Question: What type of chart is this?
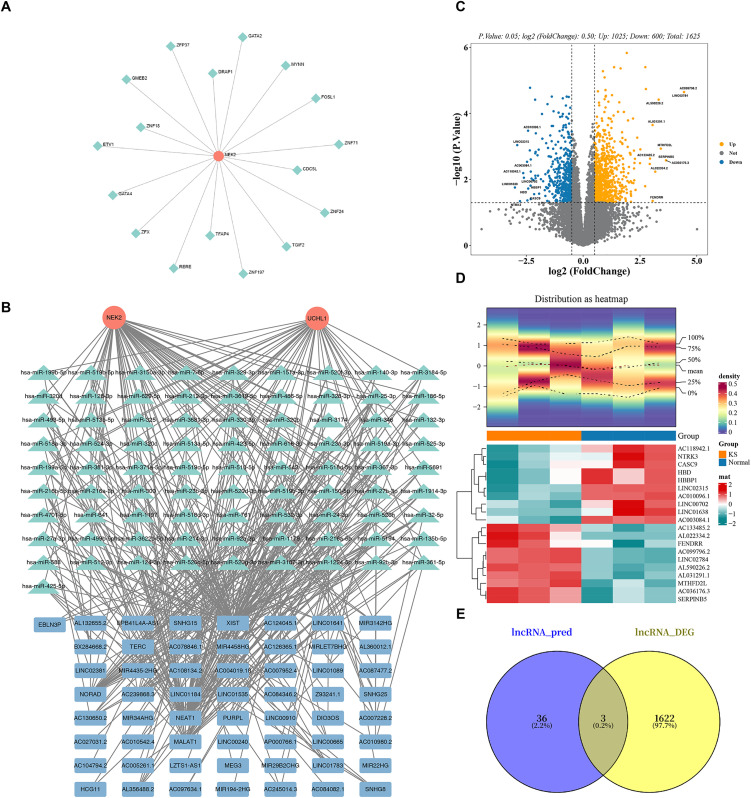
Answer: heatmap